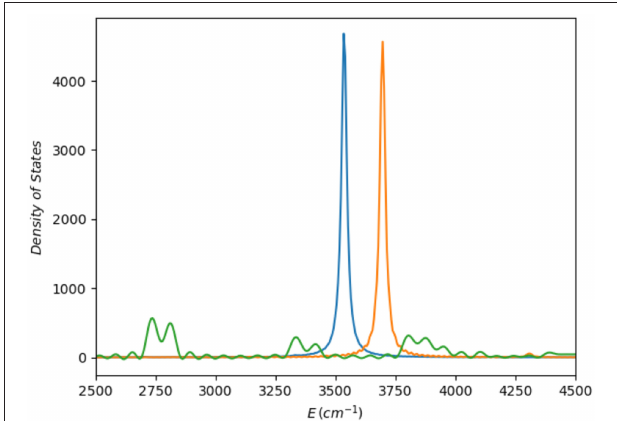
FIGURE 9 | Vibrational spectra computed as the Fourier transform of the autocorrelation function obtained after excitation of one quantum in the OH stretching vibration centered the cis conformer region: (i) green line corresponds to the PM7-MGPF PES; (ii) orange line to the SRP-MGPF ( ζ 1084 ) PES; and (iii) blue line, the reference PES ( ab initio ) (Richter et al.,